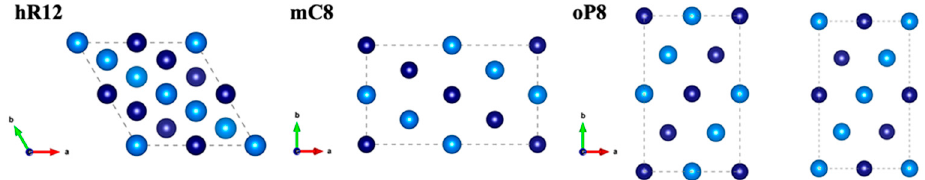
Figure 2. AFM configurations (undistorted) of the manganese sublattice in hR12, mC8 and oP8 structures: for oP8 we have considered Greedan et al. [30] antiferromagnetic alignment, while for hR12 and mC8, we have considered Singh antiferromagnetic alignment [31]. For the oP8 lattice, the 2 × 2 × 2 supercell requires two c-stacked manganese ions layers with different magnetic ordering to be modeled. Color Code: spin up blue, spin down light blue.